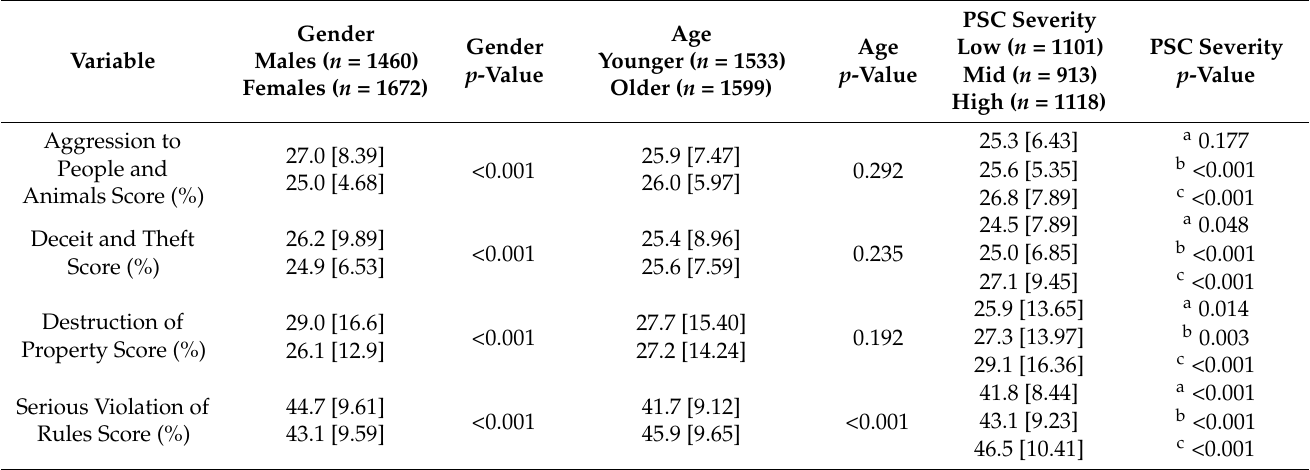
Table 4. Mean scores and standard deviations for each independent variable (Gender, Age, PSC Severity) on the sub-scores of Conduct Disorder.